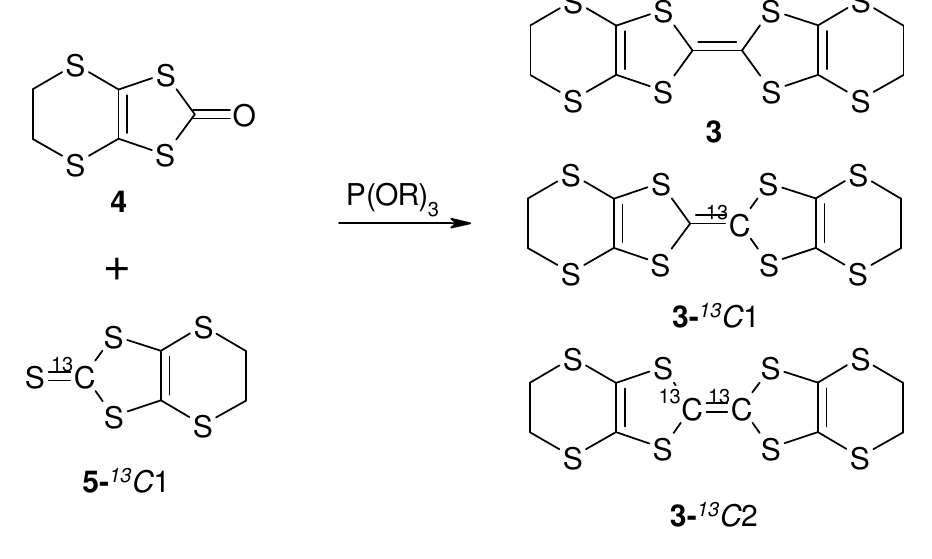
Figure 2. Cross-Coupling reaction of a ketone and a thioketone for